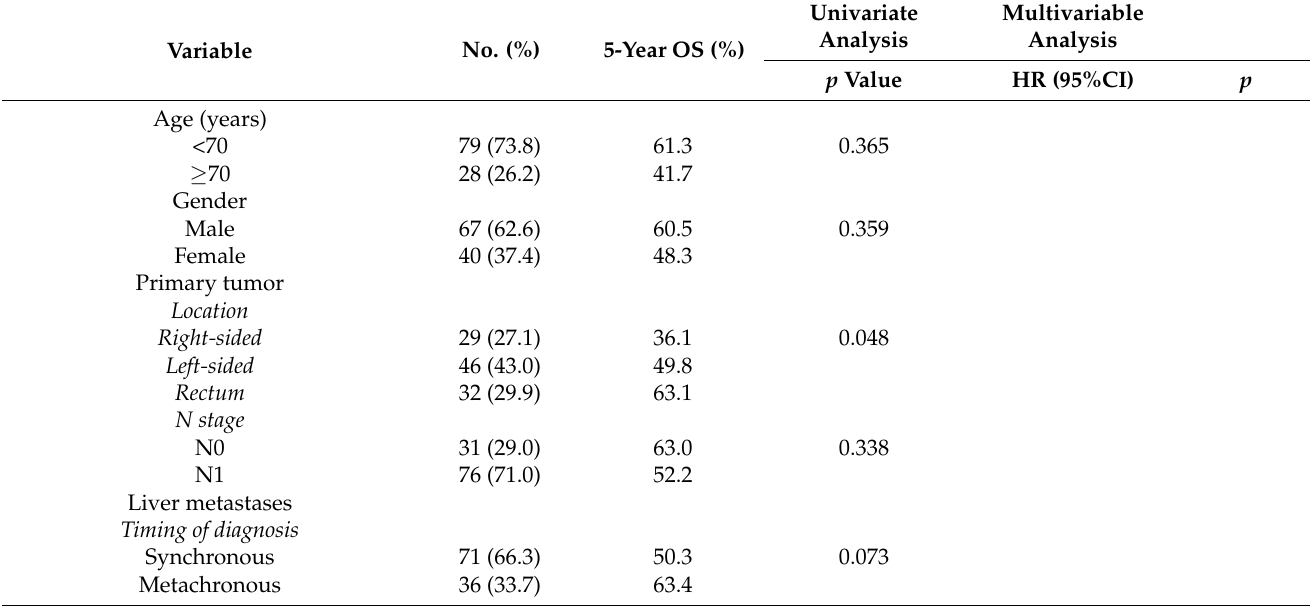
Table 3. Univariate and multivariable analysis of OS in 107